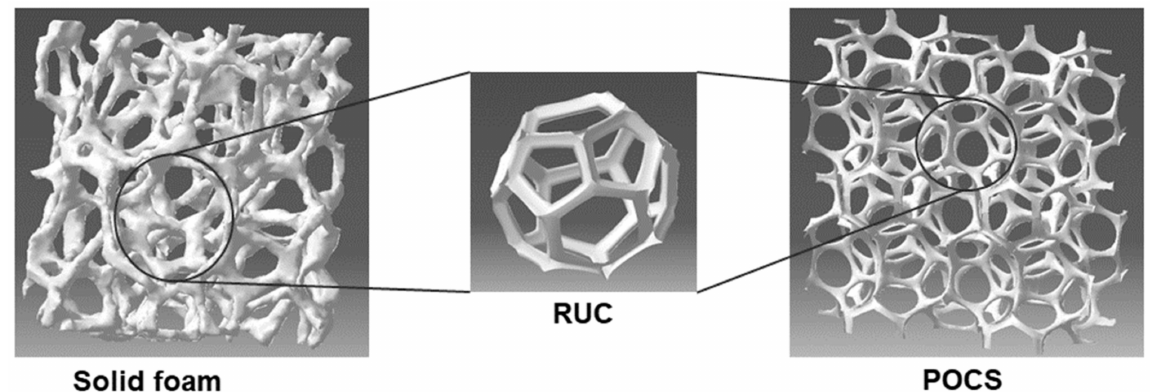
Figure 4. Solid foam substitution by